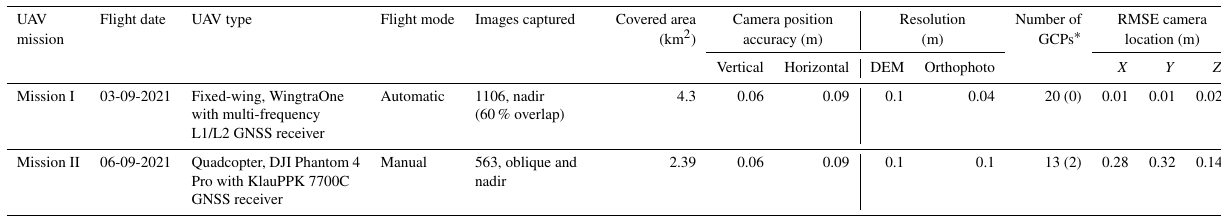
Table 1. Overview of the two UAV